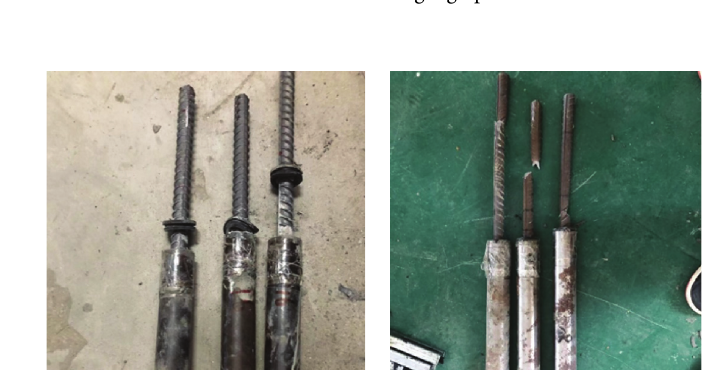
Figure 4: Measured gauge